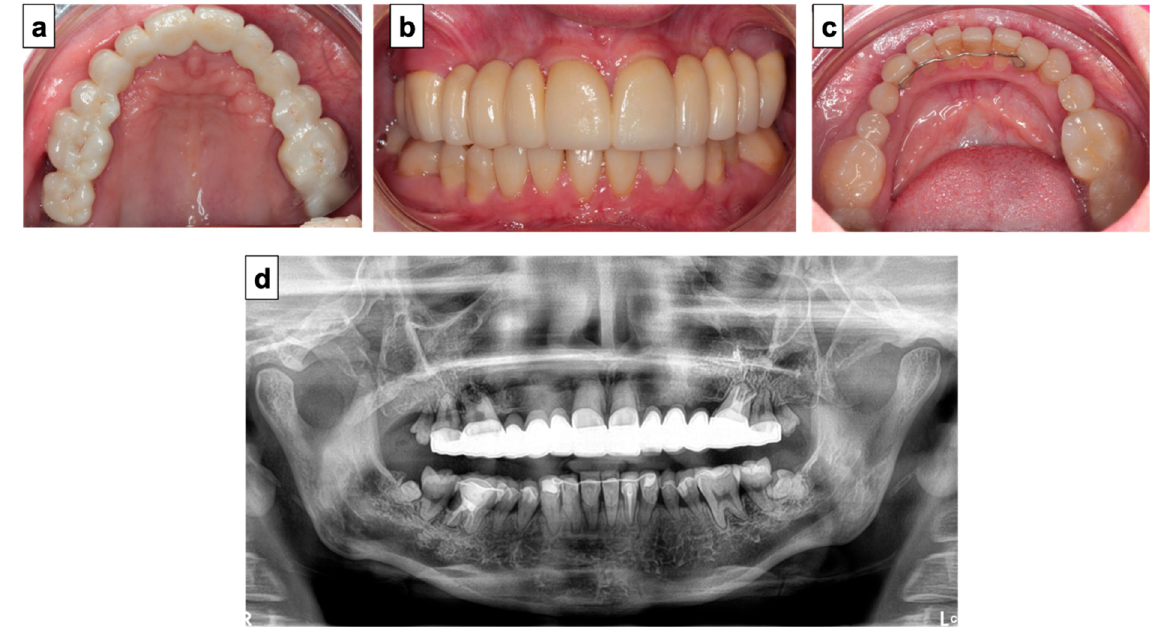
Figure 7. 18-month follow-up. ( a – d ) 18 month clinical and radiographic follow-up.